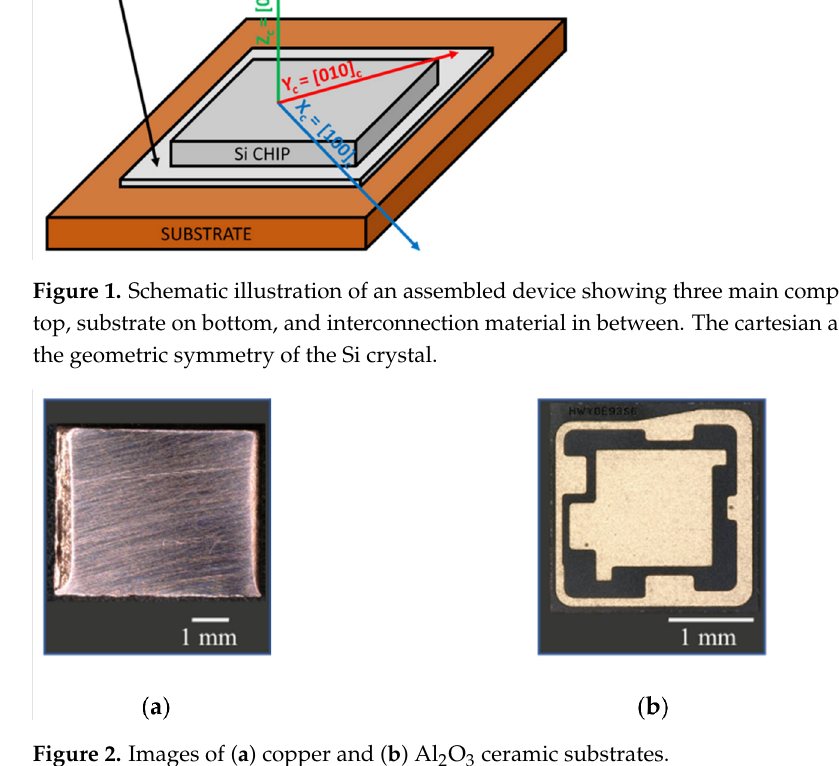
Figure 2. Images of ( a ) copper and ( b ) Al 2 O 3 ceramic